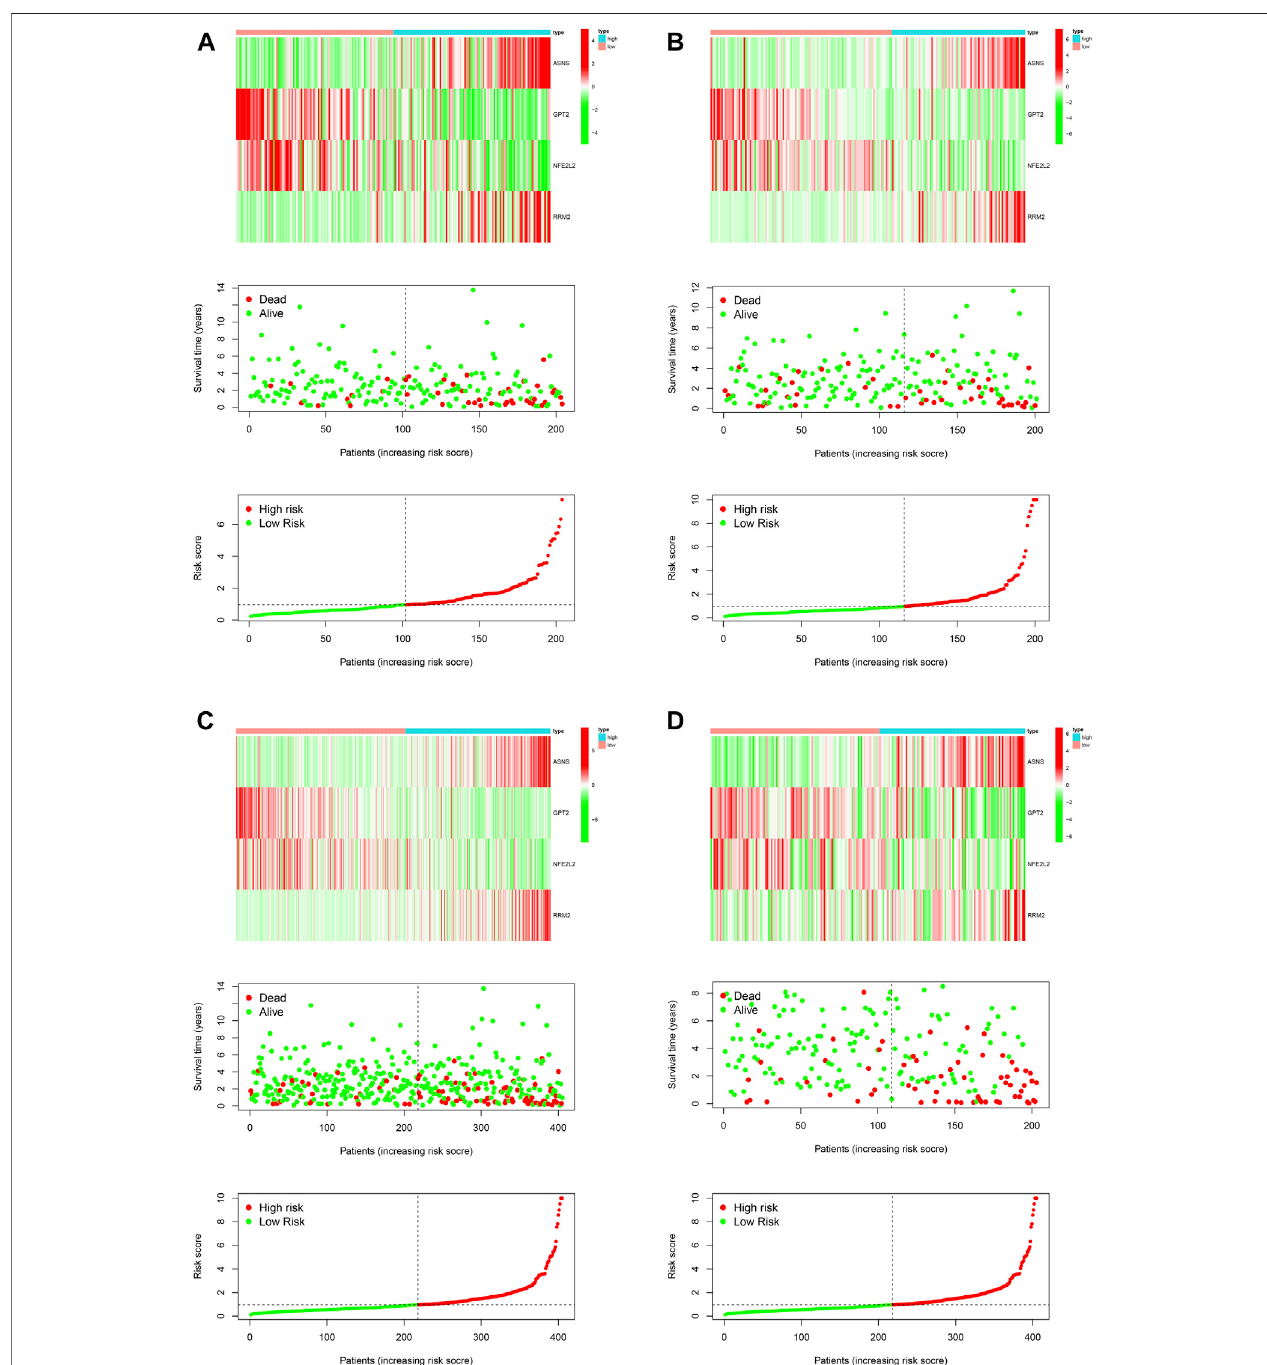
FIGURE 5 | Development and validation of a novel ferroptosis-related prognostic signature for PCa. The expression heatmap, the distribution of risk score and survival time of training cohort (A) , testing cohort (B) , the whole TCGA cohort (C) and validating cohort (D) .